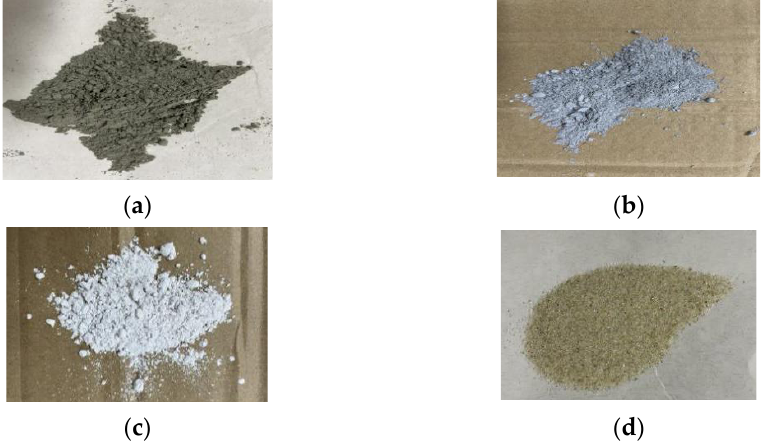
Figure 1. ( a ) FA, ( b ) SF, ( c ) GGBS, and ( d ) quartz sand used in specimens of this experiment [60]. Table 2. Main properties of the PVA fibers.